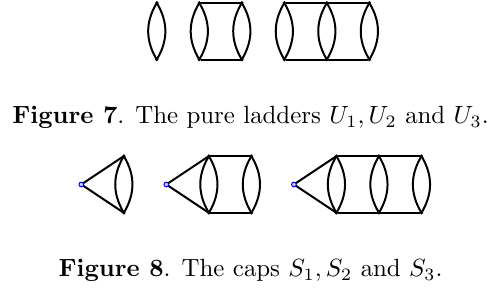
Figure 6 . One vertex reducible graph. We represented in dashed red the amputated external edges.